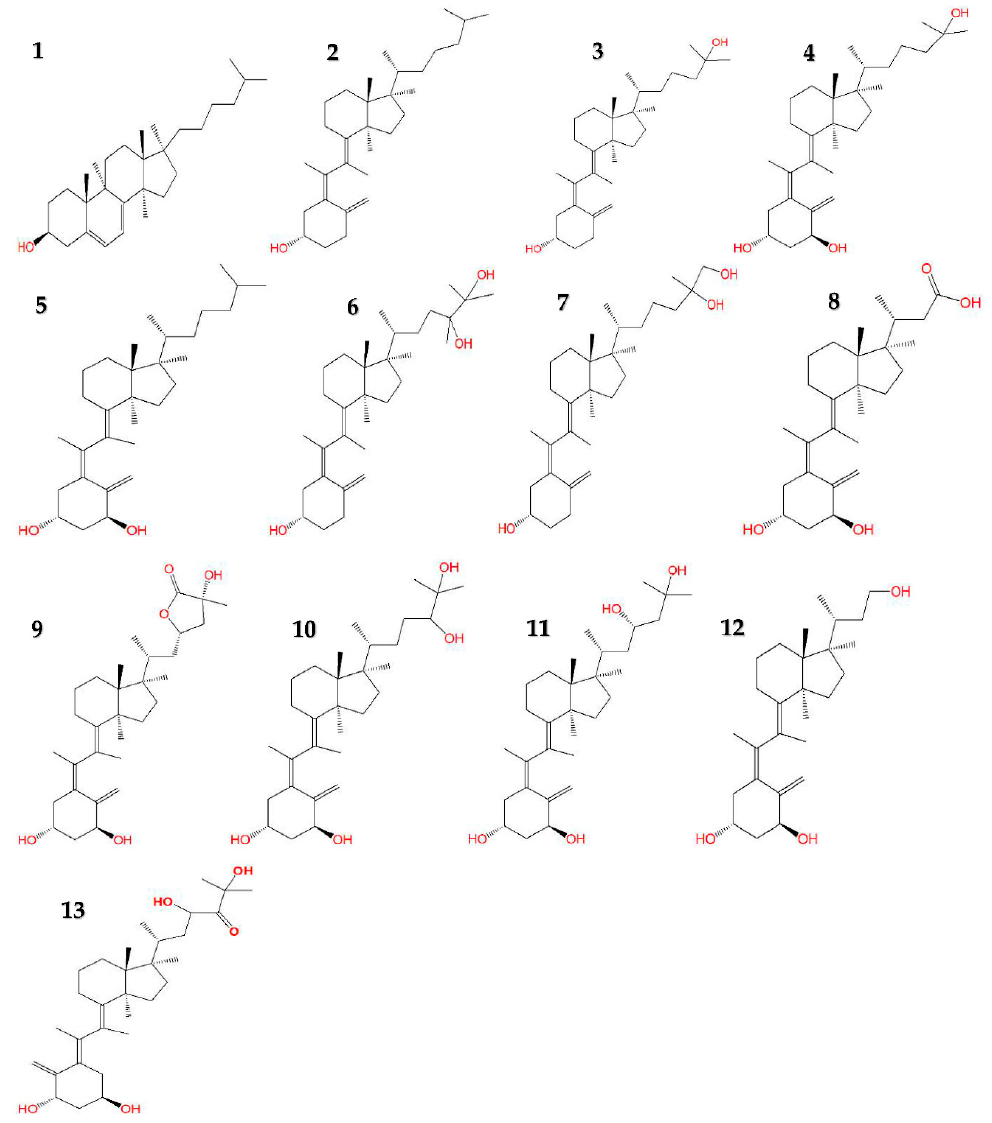
Figure 1. Chemical structures of provitamin D 3 and vitamin D 3 derivatives. 1. Provitamin D 3